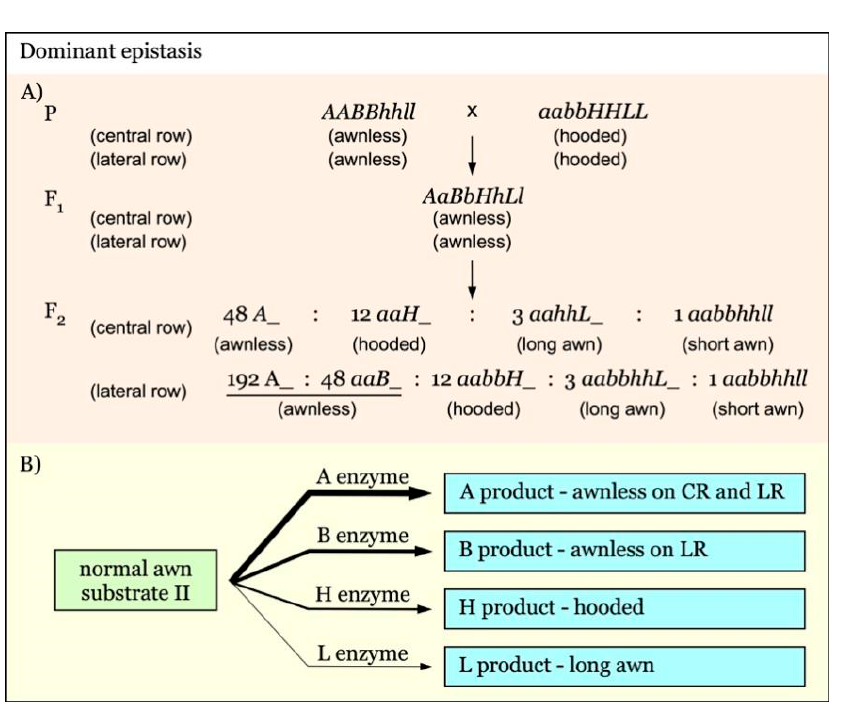
Figure 7. Model of interaction of awnness genes with multiple dominant epistatic effects. ( A ). A , B , and H are dominant epistatic genes over L . The strength of their epistatic effect is in the order of A - B - H . The A gene functions on both the central row (CR) and lateral row (LR). The B gene exerts its epistatic effect only on LR. ( B ). The final awn phenotype is determined by the supremacy of the epistatic gene. The thicker arrows indicate genes with a stronger epistatic effect.